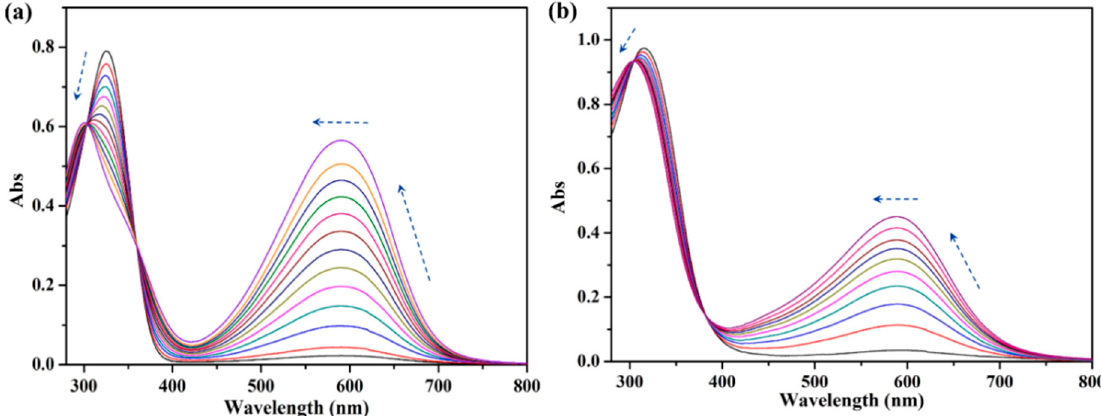
Figure 3. UV-Vis spectra monitoring chemical of ( a ) AT and ( b ) EAAO.